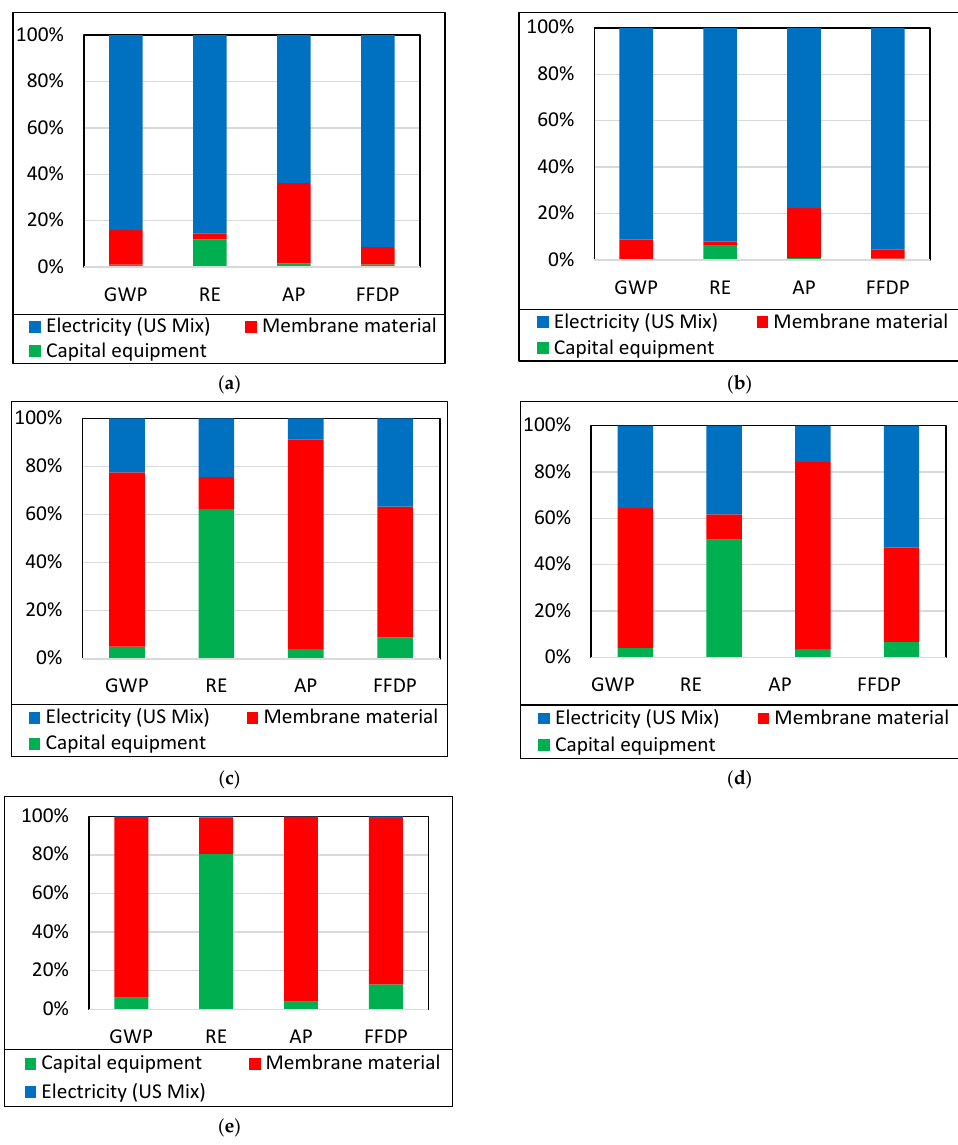
Figure 3. Analysis of contributions of the single-stage CO 2 enrichment process with ( a ) MEEP, ( b ) MEEP/CN, ( c ) Pebax LE, ( d ) Pebax HE, and ( e ) Pebax ZIF-8 membranes. Figure 4a,e show the percentage contribution of each of the fi ve membranes in a two- stage process using a 100% stacked column bar chart. In this scenario, CO 2 is enriched from 1% in N 2 to 94% CO 2 in N 2 in two stages. Each stage has a 90% recovery of CO 2 . Other parameters are the same as in the single-stage system.